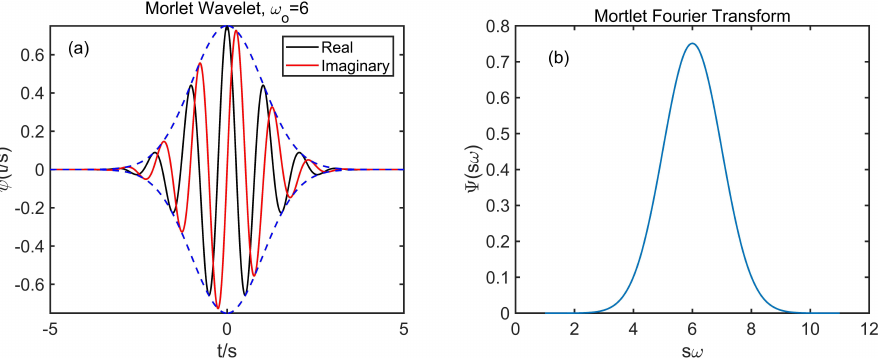
Figure 1. ( a ) The Morlet wavelet in the time domain: the real part is in blue and the imaginary in red. ( b ) The Morlet wavelet in the frequency domain (see also Figure 2 in Torrence and Compo [41]). The average of the wavelet power spectral density spectrum (panel c in Figure 2) and is given